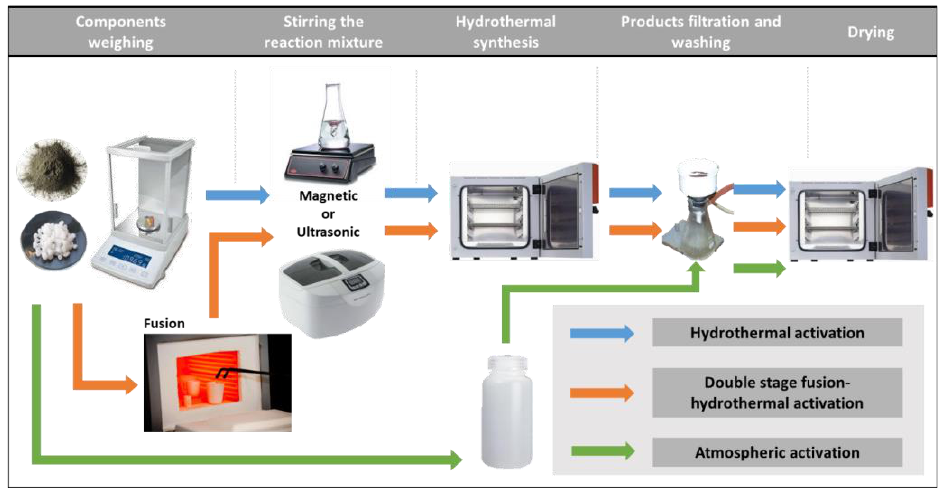
Figure 1. Synthesis of fly ash zeolites by hydrothermal activation, double-stage fusion – hydrothermal activation and atmospheric crystallization.